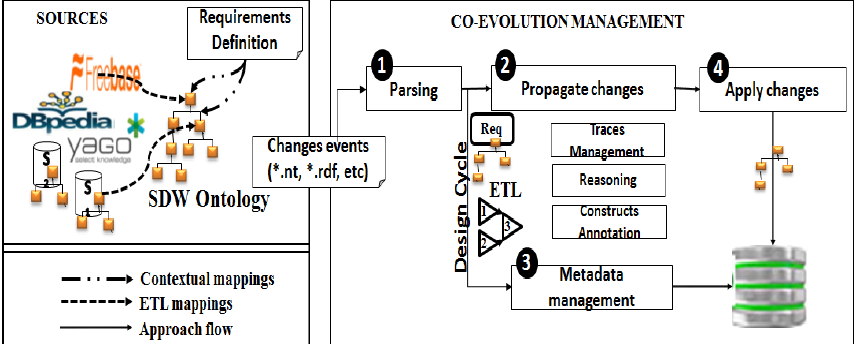
Figure 4. Proposed